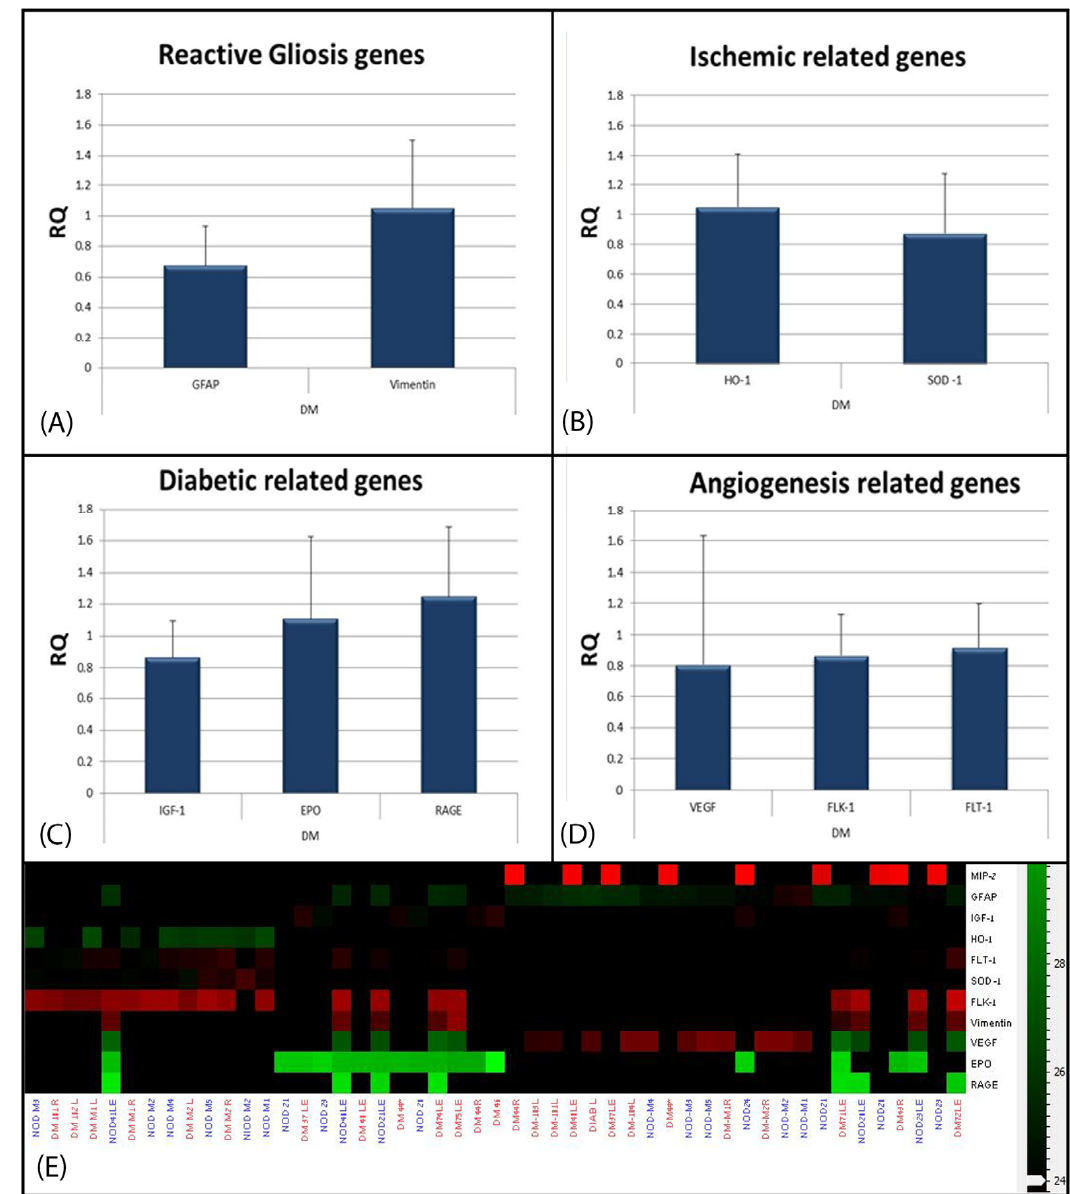
Figure 5. Molecular analysis of the diabetic retina in DMT1 mice. ( A ) Gliosis-related genes (GFAP and vimentin). GFAP levels were significantly reduced (0.35-fold, p = 0.04), and vimentin levels remained at baseline. ( B ) Oxidative stress-related genes (HO-1 and SOD-1). There was a statistically non- significant trend of a mild reduction in SOD-1 levels, with no change in HO-1. ( C ) Diabetes-related genes (EPO, IGF-1, and RAGE). EPO and IGF1 remained at baseline, and a statistically non-significant trend of a RAGE increase of 1.25-fold was noted. ( D ) Angiogenesis-related genes (VEGF-A, Flt-1, and Flk-1). No changes were noted. ( E ) Heat map of over- and underexpression of the genes investigated in this study. (ACTB served as the housekeeping